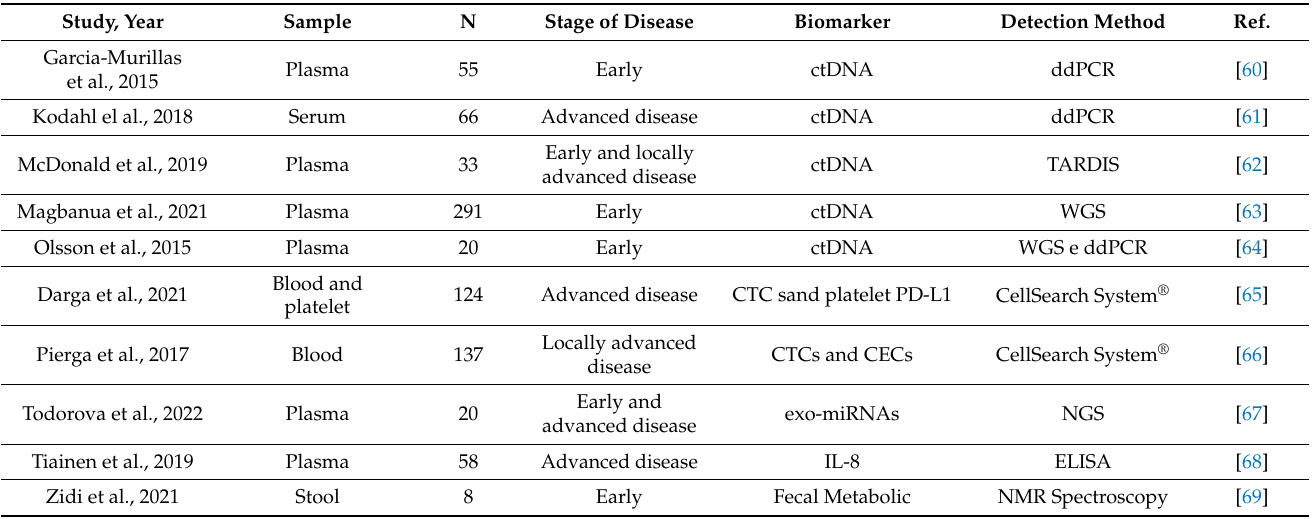
Table 3. Studies demonstrating the biomarkers for monitoring response during treatment in breast cancer using liquid